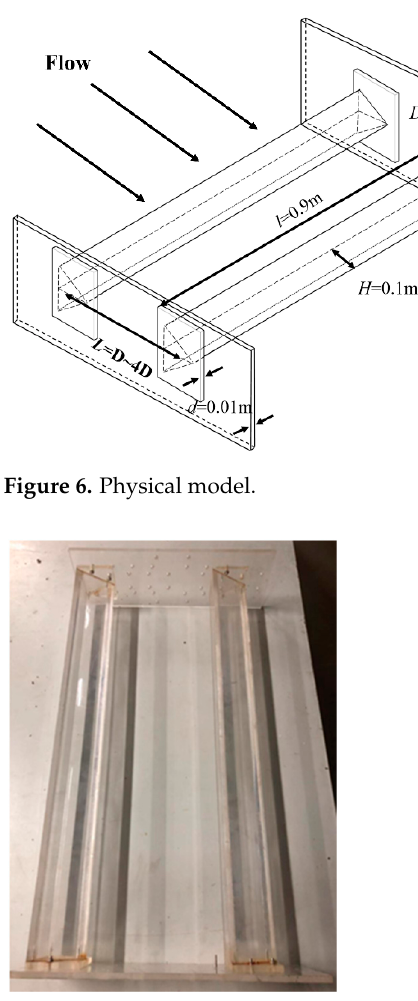
Figure 7. Actual model.